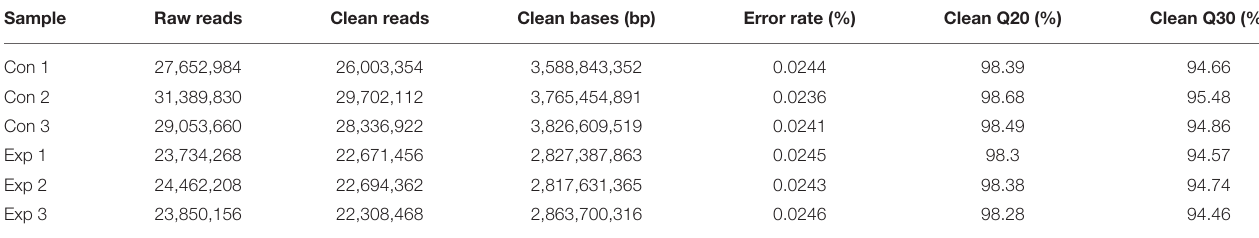
TABLE 3 | Transcriptome data summary and